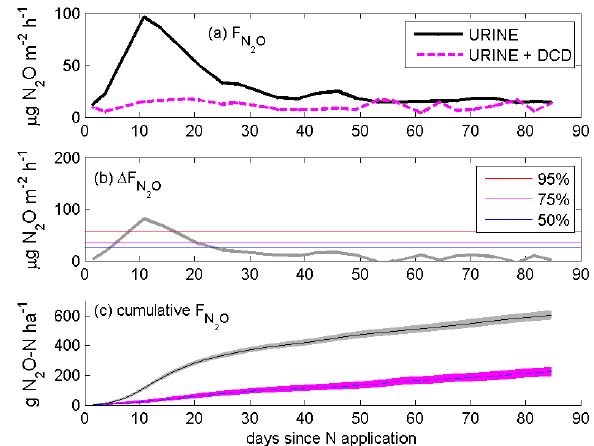
Fig. 10. Field-scale F N , 1F N and cumulative F N based 2 O 2 O 2 O on N 2 O fluxes measured from lysimeters receiving controlled N (control) and controlled N plus the nitrification inhibitor dicyandi- amide (mitigated). Data have been digitised from Fig. 2a in Di and Cameron (2006). (a) Time series of fluxes measured by static cham- bers and scaled to a whole field; (b) time series of difference in flux ( 1F N ). Horizontal lines represent the ability of the FS-NOMAS 2 O to detect the mitigation effect in a single instantaneous comparison of plots at different values of the transfer coefficient C Tr , represent- ing the 50th, 75th and 95th percentile of all C Tr measured during the Spring Experiment; (c) cumulative fluxes from the control and mitigated plots. The digitised time series of fluxes have been inter- polated to a 4h time step and errors have been estimated by boot- strapping errors from field measurements and propagated in time as in Fig.